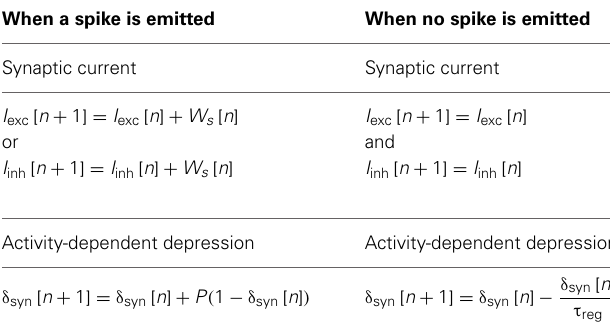
FIGURE 4 | Example of matrix design depending on the neural network. Neuron 2 (N2) is connected by an inhibitory synapse to neuron 1 (N1) and by an excitatory synapse to neuron 3 (N3). Then, on line 2 in the connectivity matrix, N2 is connected to N1, N3, and a virtual neuron (VN), indicating the end of the connection. In the synaptic weight matrix, the synapses for neuron 2 (S2) have a negative weight for the inhibitory synapse and a positive weight for the excitatory synapse. Note the correspondence of its position in both